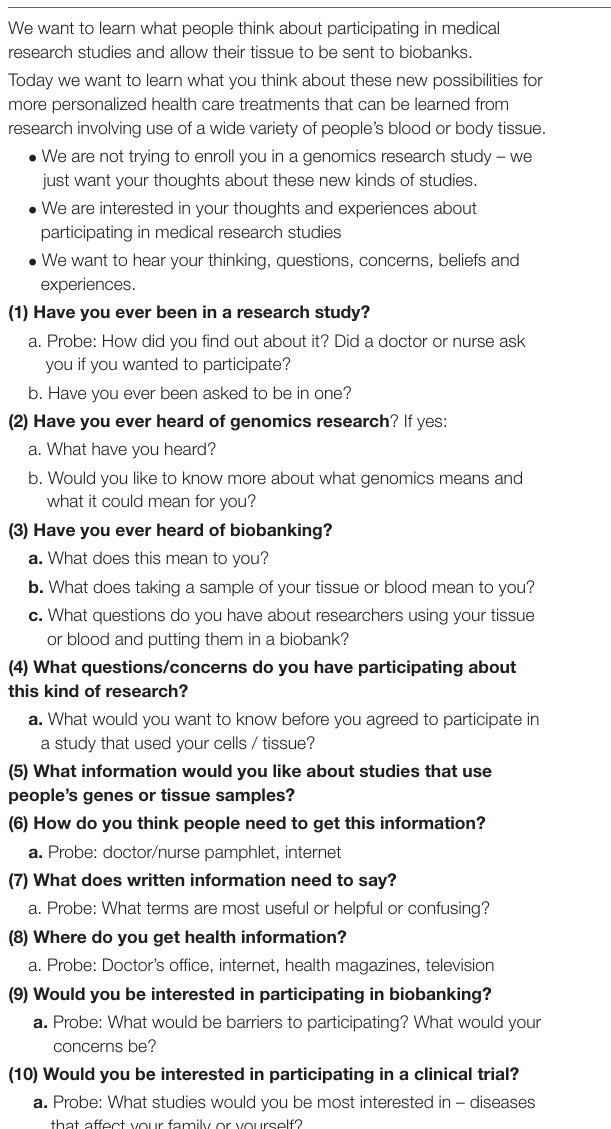
TABLE 2 | Moderators guide for patient genomic focus